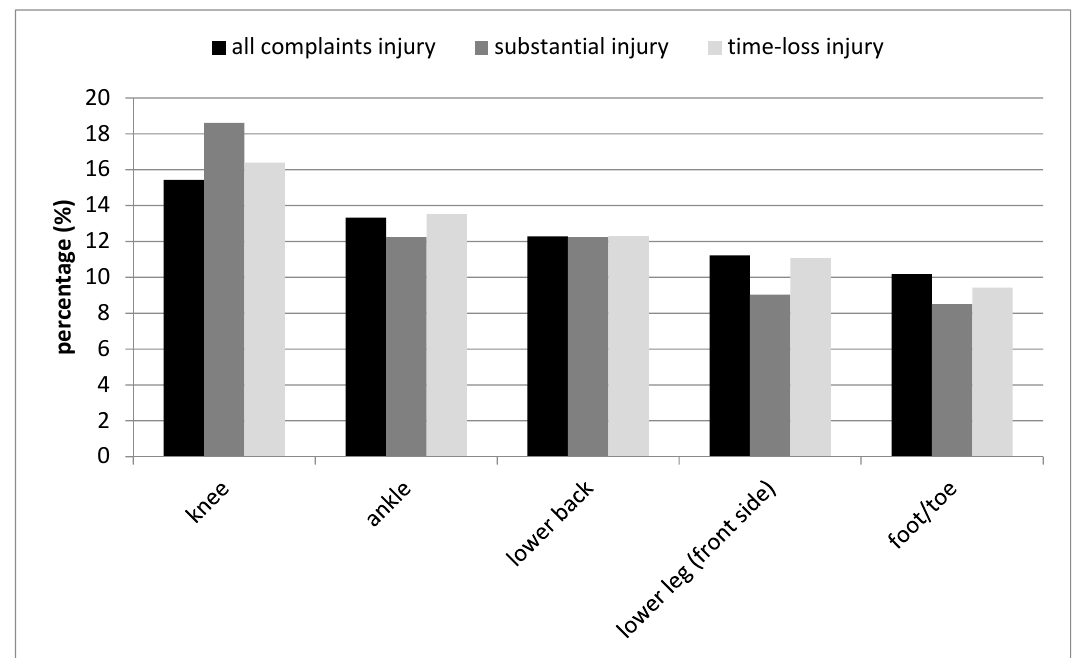
Figure 1. Top five most reported injury locations according to the three injury definitions.